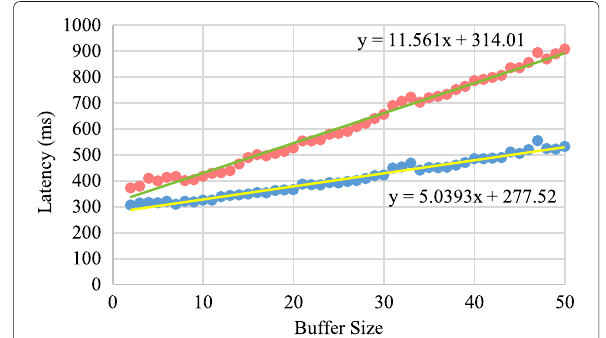
Fig. 9 Latencies of a single transmission transaction with respect to different buffer sizes, together with the linear regression analyses. The upper scatters indicate the latency of report buffering and uploading, while the lower scatters indicate the uploading latency only